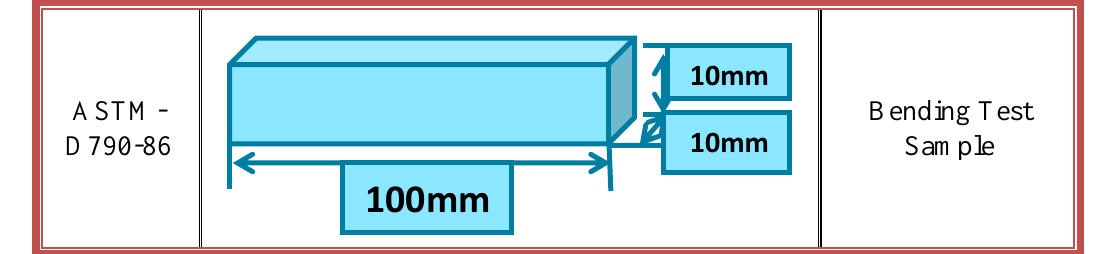
Fig. 1: Global measurement of bending